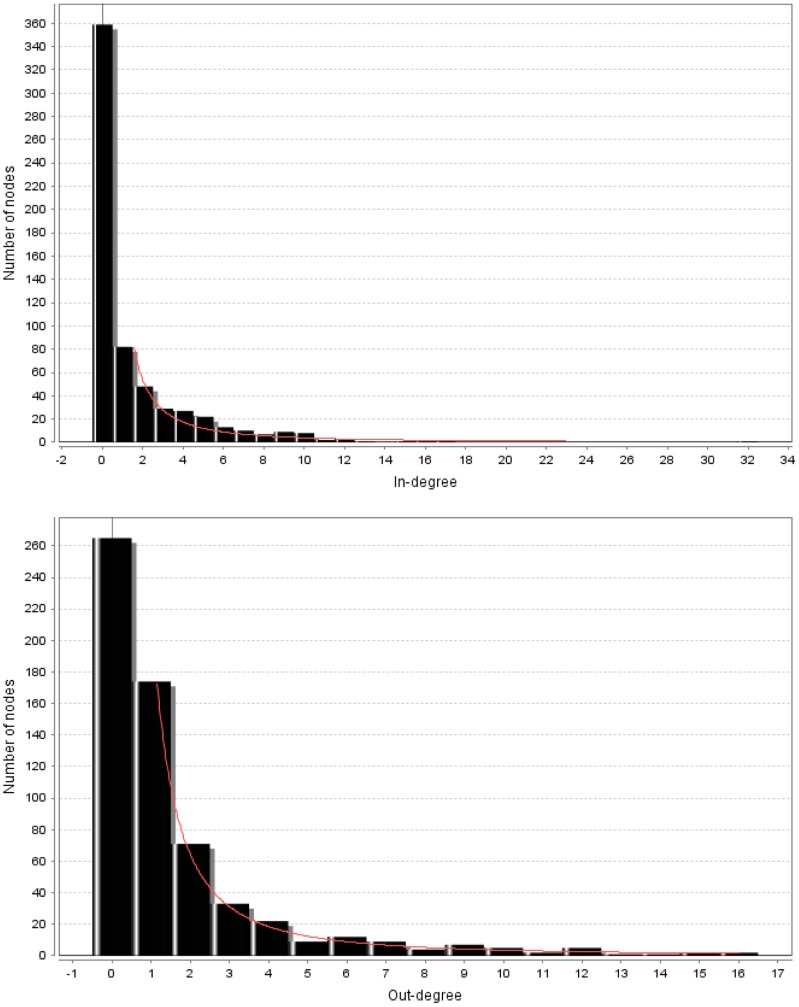
The topology of the complete CoMi network analysis of the in-degree (GO term) and out-degree (miRNA) nodes of the network fit a power law distribution.The Y-axis represents the number of nodes, the X-axis is the number of In-degree/Out-degree nodes. These graphs indicate that the generated networks are typical scale-free networks.